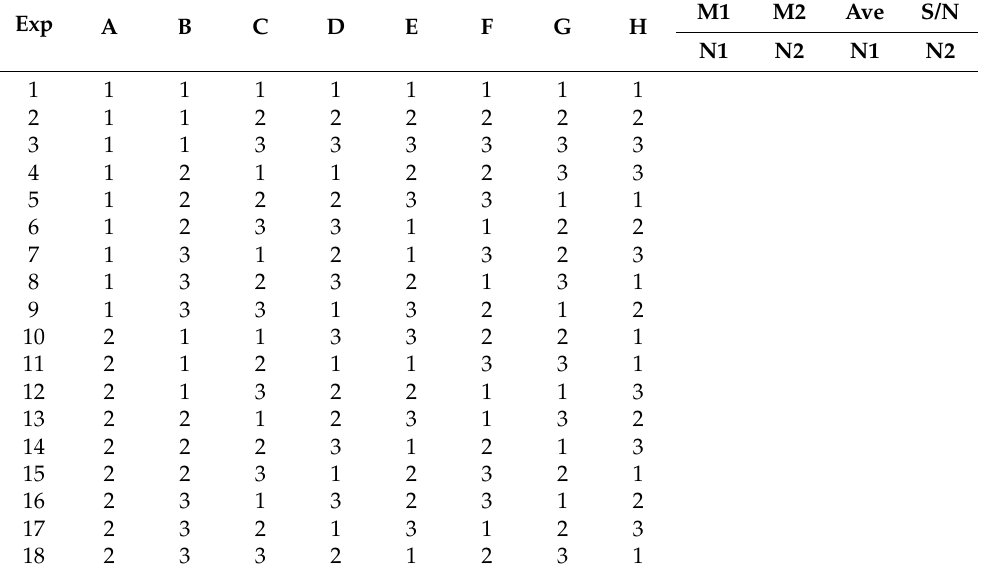
Table 3. Orthogonal array of L 18